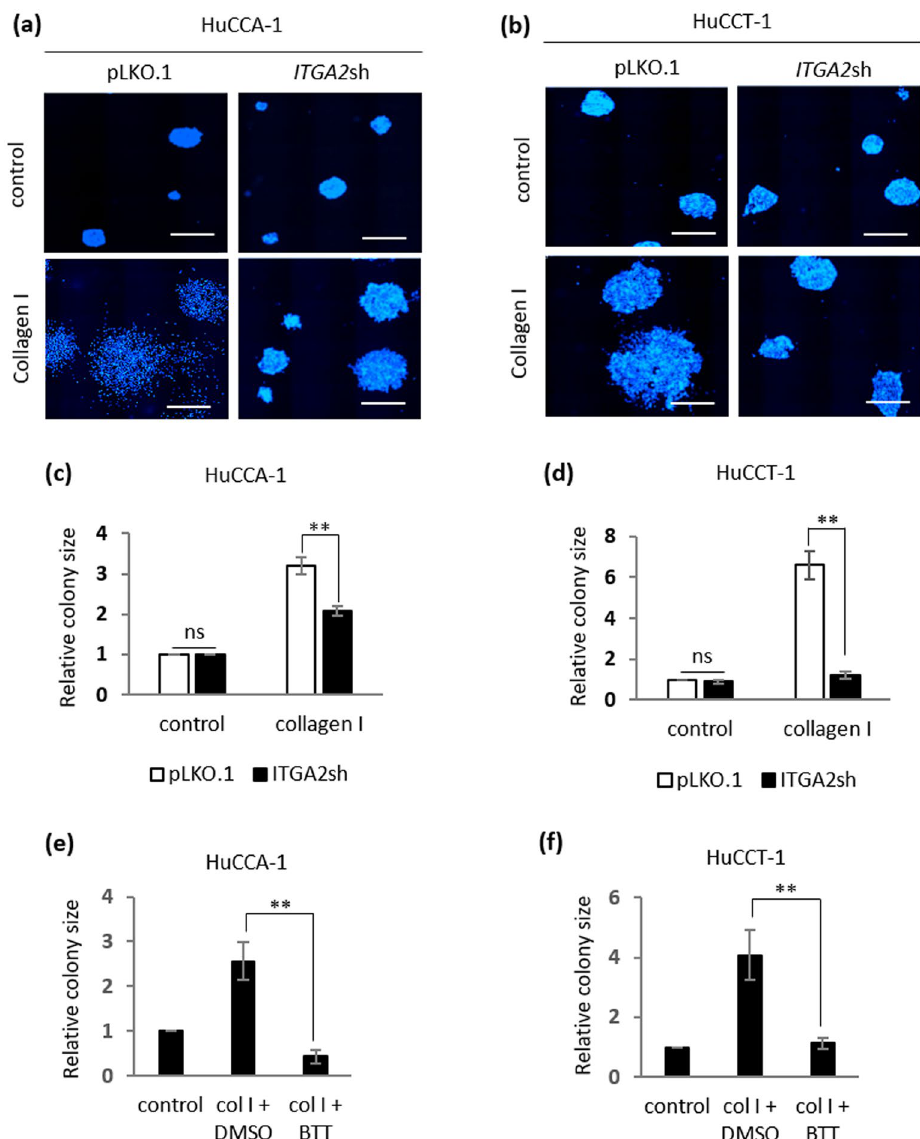
Figure 7. Interaction between collagen type I and integrin α2 is necessary for collagen type I-induced clonogenic growth of iCCA cells. HuCCA-1 and HuCCT-1 cells stably expressing pLKO.1 vector control or pLKO.1- ITGA2 sh ± 10 μg/mL collagen type I in clonogenic assays for up to 10 days. ( a,b ) DAPI- stained HuCCA-1 and HuCCT-1 colonies. Scale bar = 1000 μm. Quantification of colony size from ( c ) HuCCA-1 ± pLKO.1 vs. HuCCA-1 ± pLKO.1- ITGA2 sh and ( d ) HuCCT-1 ± pLKO.1 vs. HuCCT-1 ± pLKO.1- ITGA2 sh. Quantification of ( e ) HuCCA-1 ± DMSO or BTT-3033 (5 μM) and ( f ) HuCCT-1 ± DMSO or BTT- 3033 (5 μM) in the presence or absence of 10 μg/mL collagen type I. All bar graphs represent the mean ± SD from at least three independent experiments. The Student’s t-test was used to calculate p -value. ns, not significant; ** p <